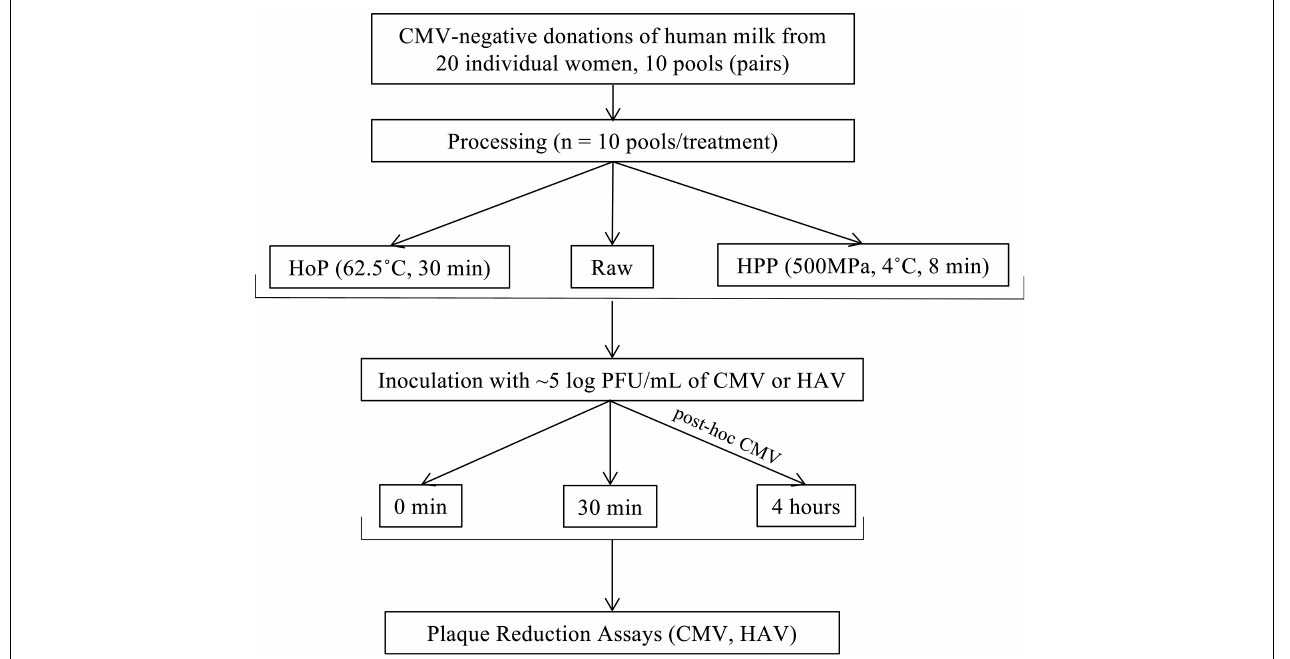
FIGURE 1 | Study flow diagram. The flow chart demonstrates sample collection, processing, and experimental design. HoP, Holder pasteurization; HPP, high-pressure